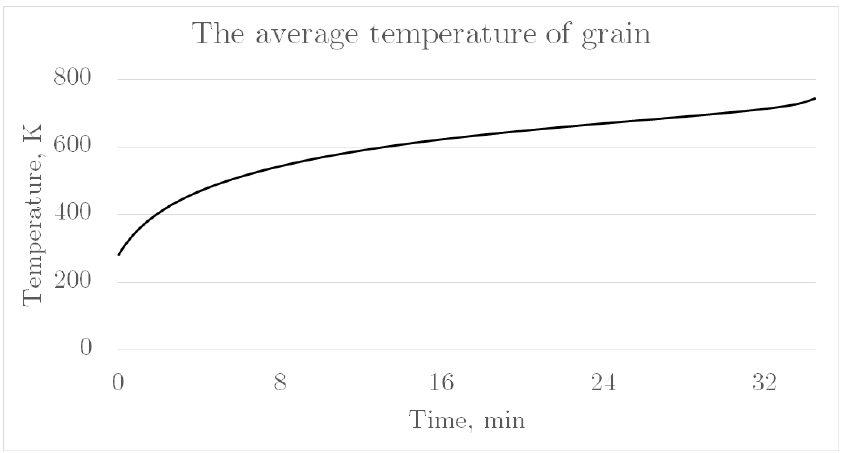
Figure 12. Dynamics of the average temperature of the catalyst